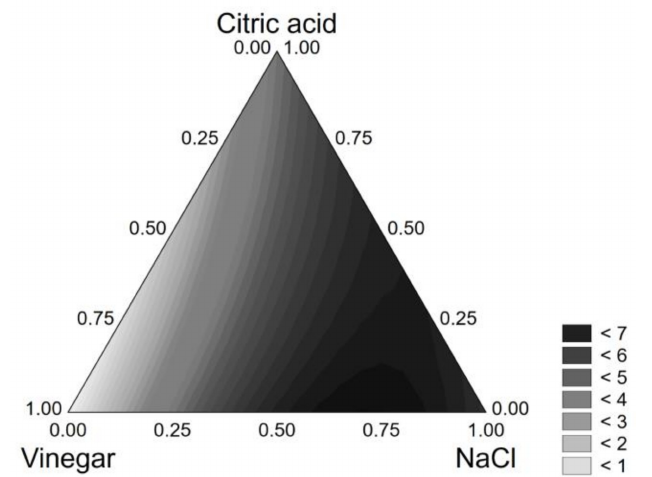
Figure 4. Ternary plot for the viability loss of B. animalis subsp. lactis DSM 10140 after 24 h in the model